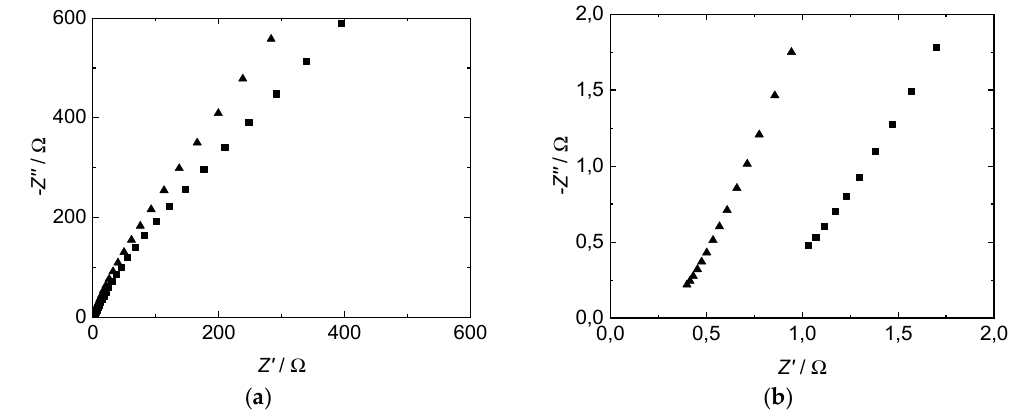
Figure 4. Measured through-plane impedance of Nafion™ 117 ( ∎ ) and 3M D825 ( ▲ ) ionomer membranes, plotted as Nyquist diagram. ( a ) Whole frequency spectrum. ( b ) Zoom.